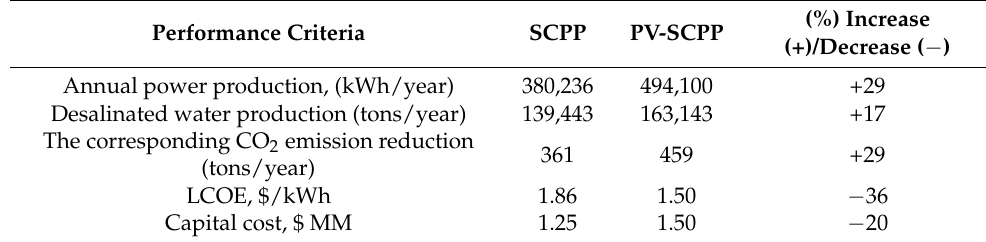
Table 4. Comparative performance of the PV-SCPP versus the conventional